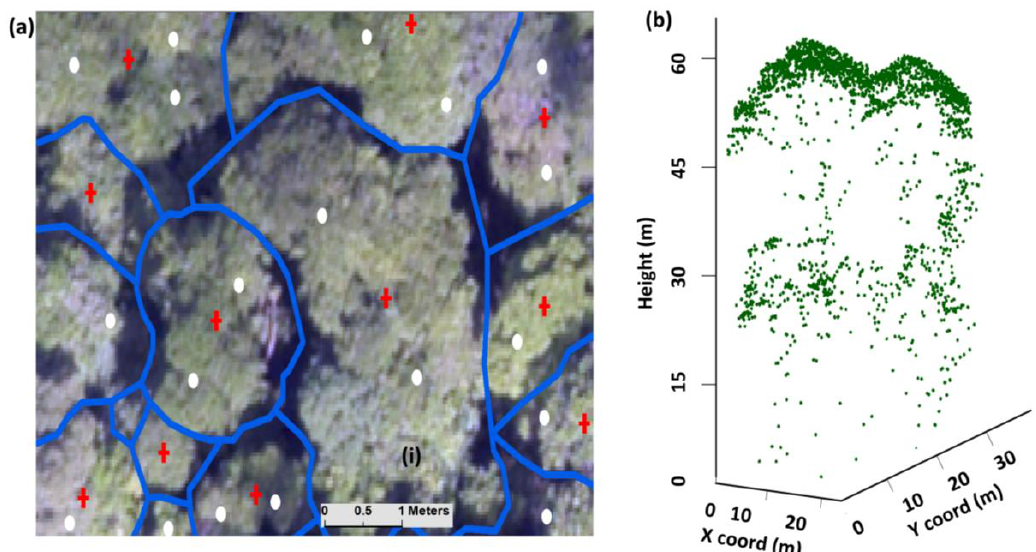
Figure 8. ( a ) Orthophoto with watershed segments (blue), a field reference tree (white) and local maxima (red cross), and ( b ) LiDAR point cloud for the i segment.